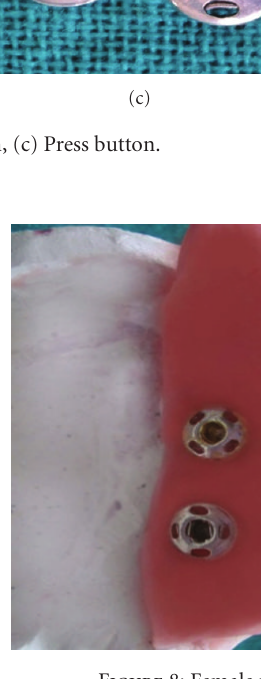
Figure 8: Female